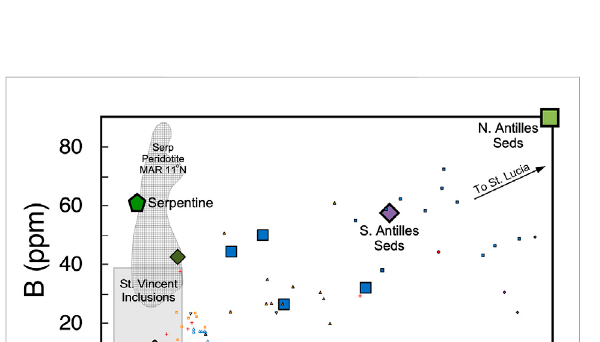
FIGURE 8 Variation of lithium and boron. Caribbean lava forms a roughly linear array for most samples whereas samples from Martinique and Dominica show both higher B and higher Li. Melt inclusions (Cooper et al., 2020) show similar trends but more variation with greater B and Li enrichment in the central islands. Average serpentine (green pentagram) is from Dessimoulie et al., 2020, and the fi eld for serpentinized peridotite from the mid- Atlantic Ridge (MAR) is from Boschi et al. (2013). 2 σ error are encompassed by the large symbols for whole rock (see Supplementary Tables SD,